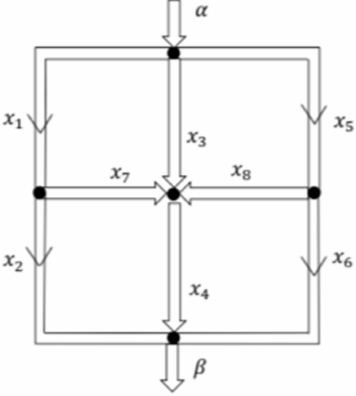
Figure 2. Flow distribution.